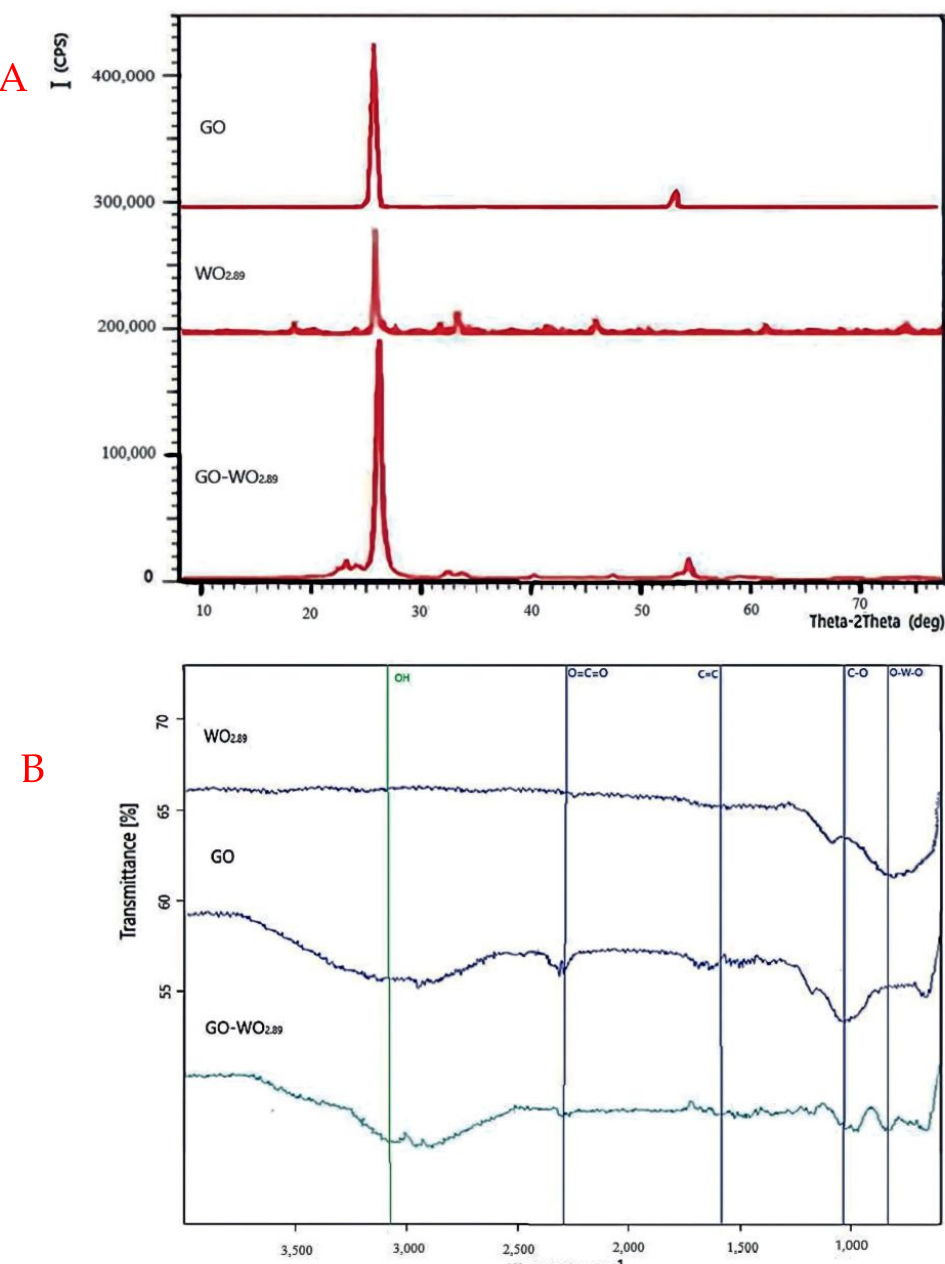
Figure 4. ( A ) XRD analysis of (GO, WO 2.89, and GO − WO 2.89 ), ( B ) FT − IR analysis of